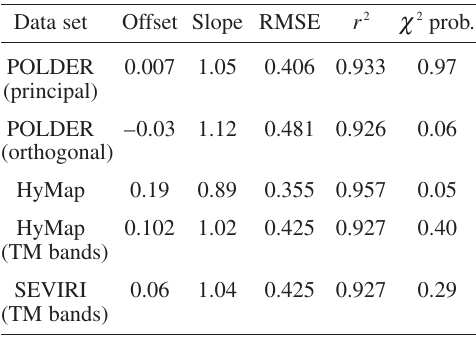
Table I. Statistics of the correlation between in situ measurements and retrievals of